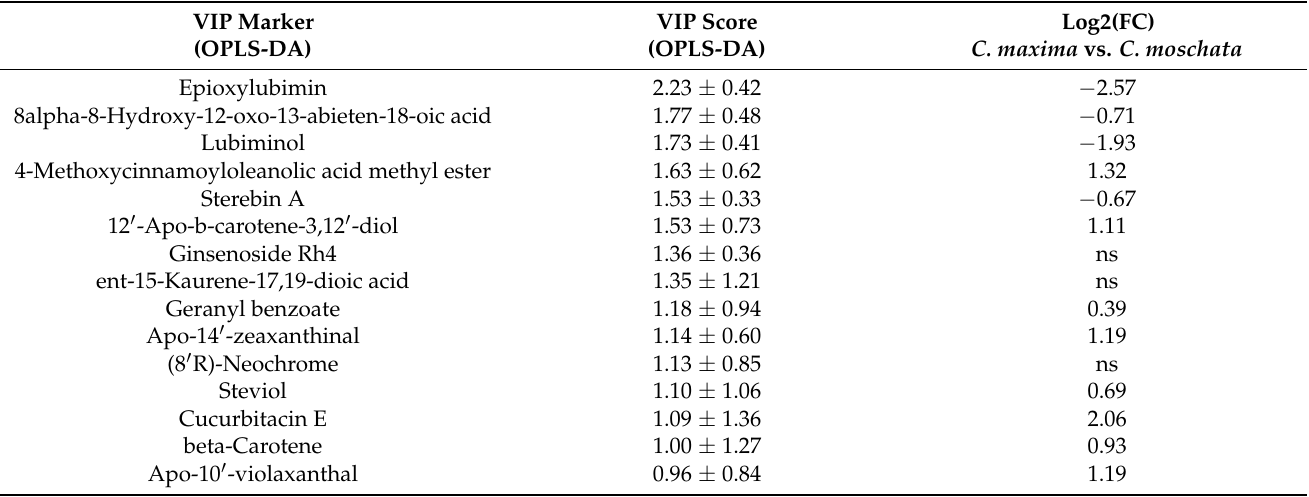
Table 2. Discriminant terpenoids according to the comparison between the two different plant species, C. maxima and C. moschata . Compounds were identified by the VIP (variable importance in projection) approach following OPLS-DA discriminant analysis. The VIP scores (a measure of variable’s importance in the OPLS-DA model) and the cvSEs are also shown. The VIP scores (measure of variable’s importance in the OPLS-DA model) and the corresponding cvSEs (cross-validated standard errors) together with the Log2 fold-change values (FC > 1.1, p < 0.05) for the comparison C. maxima vs. C. moschata are also provided. ns = not